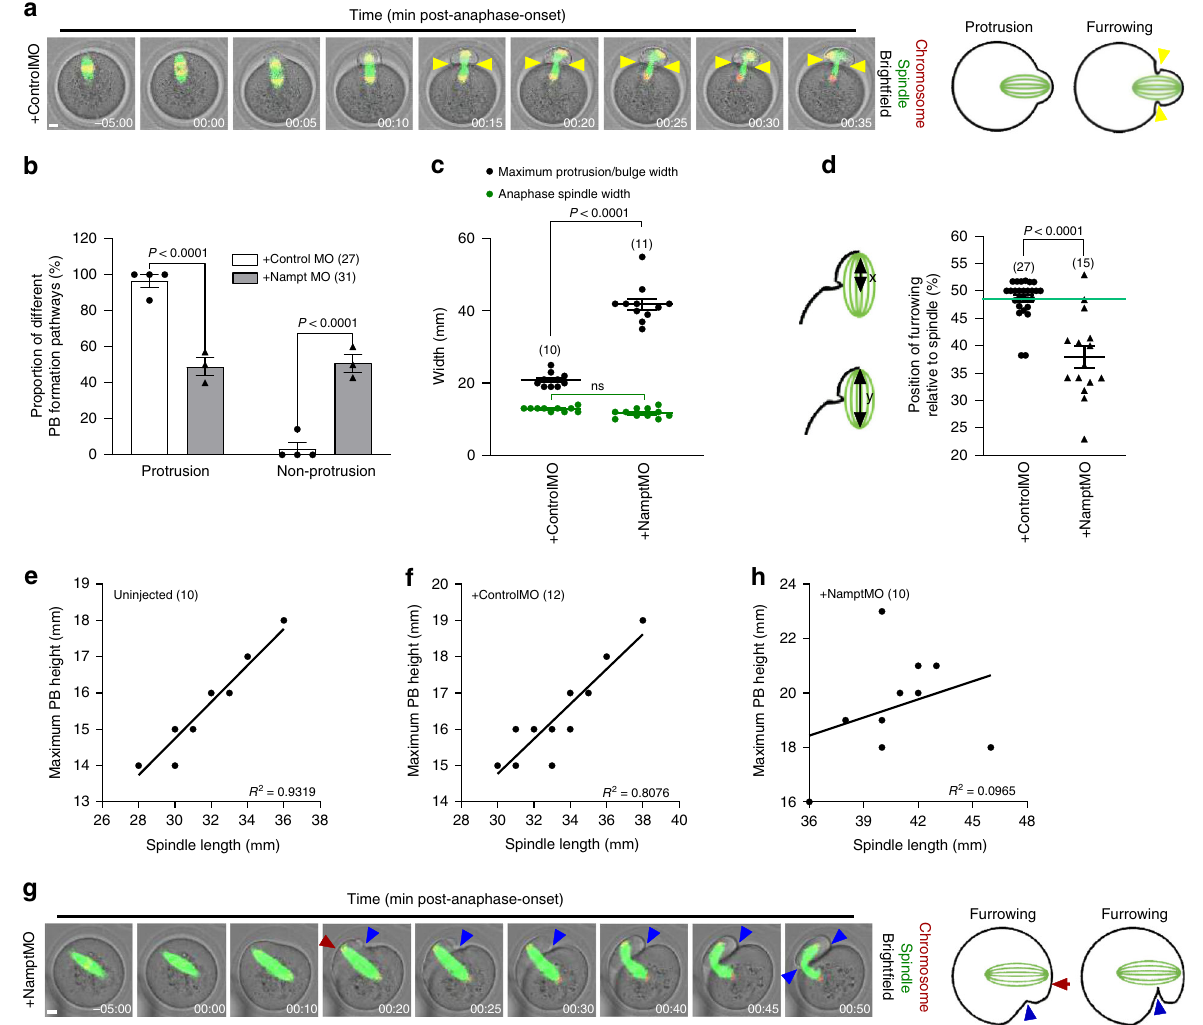
Fig. 5 Characteristics of protrusion and non-protrusion pathways. a Shown is a panel comprised of selected frames from representative time-lapse series of mock-depleted oocytes with SiR-tubulin-labelled spindles and expressing H2B-RFP to label chromosomes. Yellow arrowheads highlight the position of symmetrical furrowing occurring at the base of the protrusion in a control. Shown to the right is a schematic of the protrusion pathway. Scale bar, 10 µ m. Representative images from three independent experiments are shown. b Proportions of mock- and Nampt-depleted oocytes which undergo protrusion- and non-protrusion pathways for PB formation. c Spindle widths and maximum protrusion/bulge widths. d Position of furrowing along the length of the spindle. The distance between the leading pole and the position along the spindle that is abutted by the ingressing furrow ( x ) was expressed as a percentage of the total spindle length ( y ) in mock-depleted and Nampt-depleted oocytes as illustrated in the schematic. Green line, highlights the mean value for mock-depleted oocytes. e – h Correlation between maximum PB height and spindle length in uninjected ( e ), mock-depleted ( f ) and Nampt- depleted oocytes ( h ). g Shown is a panel comprised of selected frames from representative time-lapse series of Nampt-depleted oocytes with SiR-tubulin- labelled spindles and expressing H2B-RFP to label chromosomes. Blue arrowhead highlights unilateral furrowing in the absence of a clear protrusion. Red arrowhead highlights the bulge. Shown to the right is a schematic of the non-protrusion pathway. Scale bar, 10 µ m. Representative images from three independent experiments are shown. Times are h:min relative to anaphase-onset. Oocyte numbers are shown in parenthesis from three independent experiments ( b – f , h ). Data in graphs are presented as the mean ± SEM. Data points are shown in b . P- values are shown in the graphs, ns denoted P > 0.05. Statistical comparisons were made using either two-way ANOVA in b and c or a two-tailed Student ’ s t -test in d . See also Supplementary Movies 6 and 7. Source data are provided as a Source Data fi